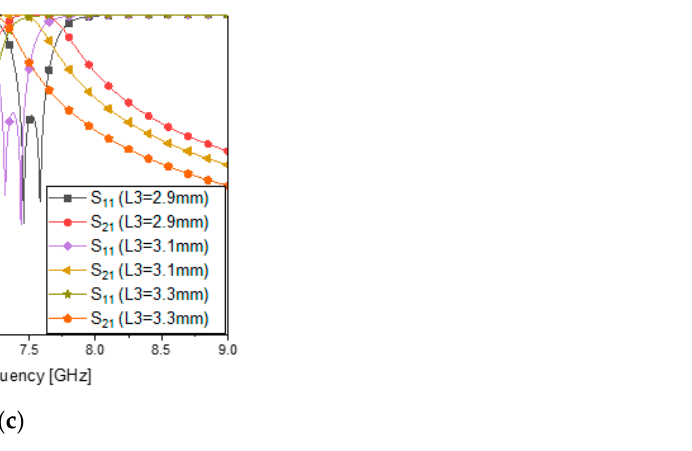
Figure 9. Parametric sweep to know what possibly causes the frequency shift of the BPF of the second order as an example. ( a ) S 11 vs. variation in L3. ( b ) S 21 vs. variation in L3. ( c ) S 11 and S 21 vs. variation in L3.